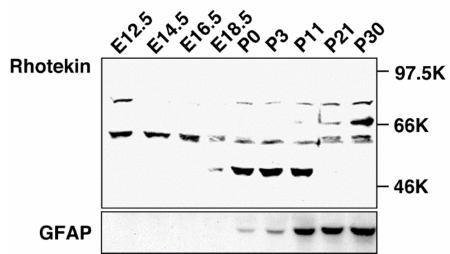
Figure 3. Developmental change of Rhotekin in the rat brain. Cholate extracts of brains at various stages were subjected to SDS-PAGE followed by Western blotting with anti-Rhotekin ( top ) or anti-GFAP ( bottom ). Molecular markers are at right. (Adapted from Reference